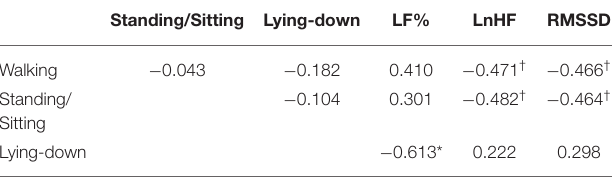
TABLE 6 | Correlations among HRV-based variables and work postures ( N = 16).